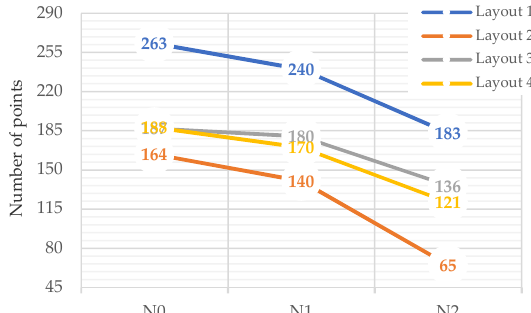
Figure 10. Number of points of the T 2 control charts.